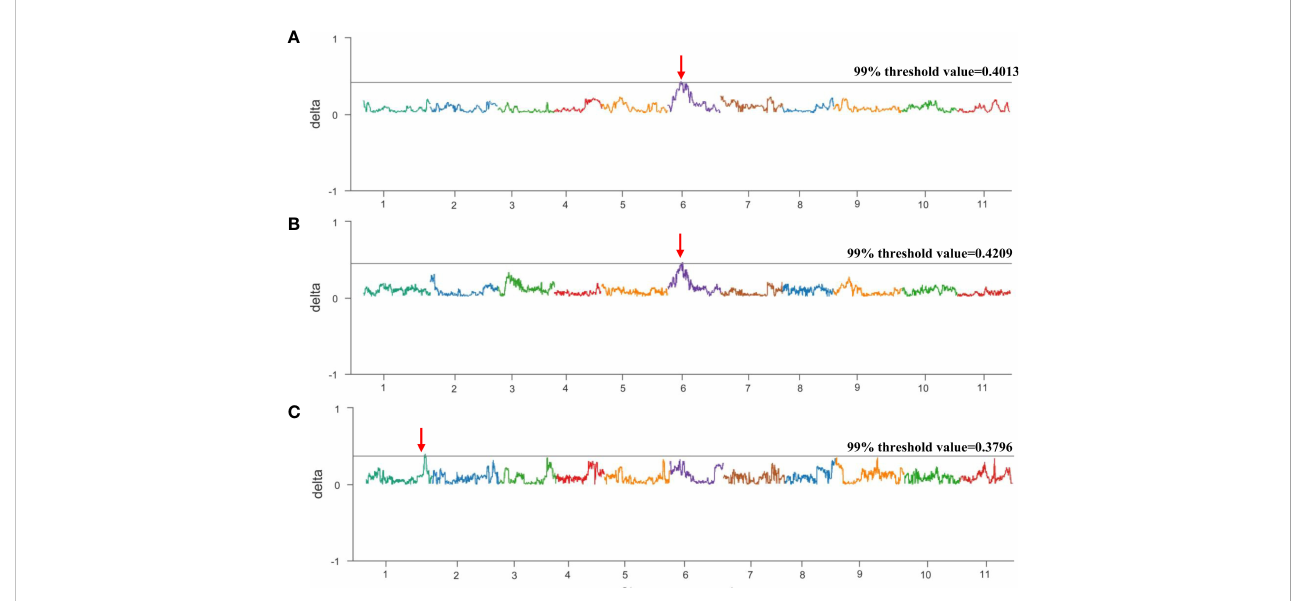
FIGURE 3 Bulked segregant analysis (BSA) of the BC 1 F 1 population. (A) D (SNP index) graph from BSA-seq analysis between the egusi pool and non-egusi1 pool. (B) D (SNP-index) graph from BSA-seq analysis between egusi pool and non-egusi2 pool. (C) D (SNP-index) graph from BSA-seq analysis between egusi pool and non-egusi3 pool. The X-axis represents the chromosome, and the Y-axis represents D (SNP index). The dark gray line is the 99% threshold value; the region indicated by the red arrow is the putative